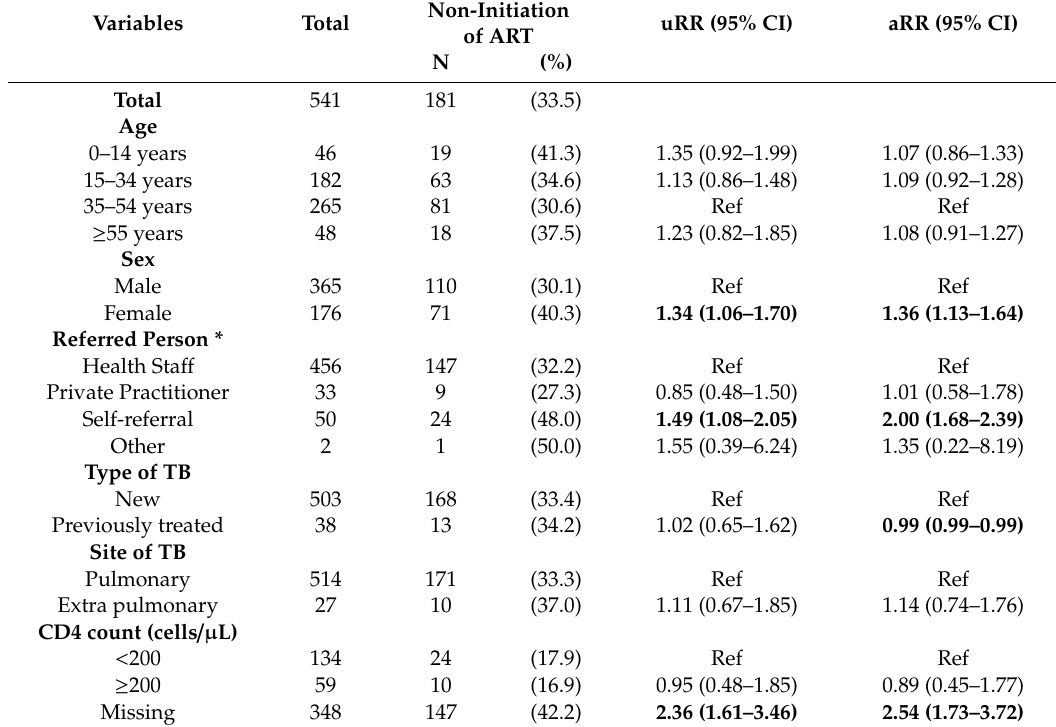
Table 2. Factors that are associated with non-initiation of ART among ART-naïve HIV-infected TB patients registered in the public health facilities of Ayeyawady Region of Myanmar, between July 2017 and June 2018 (N =